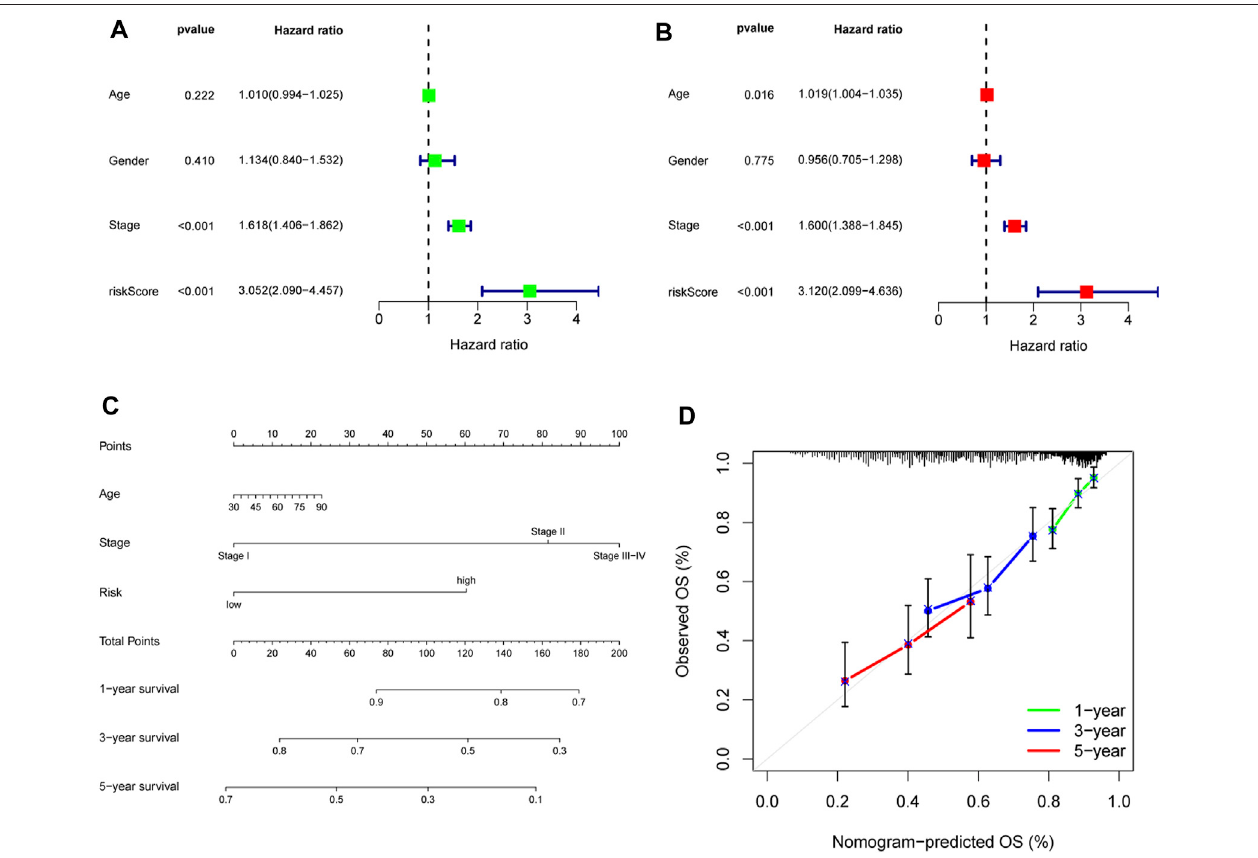
FIGURE 4 | Construction and validation of a nomogram. Univariate (A) and multivariate (B) Cox regression analyses of age, gender, stage, and risk score. (C) NomogramforpredictingtheOSofLUADpatientsat1,3,and5 years. (D) CalibrationcurvesofthenomogramforOSpredictionat1,3,and5 years.OS,overallsurvival; LUAD, lung